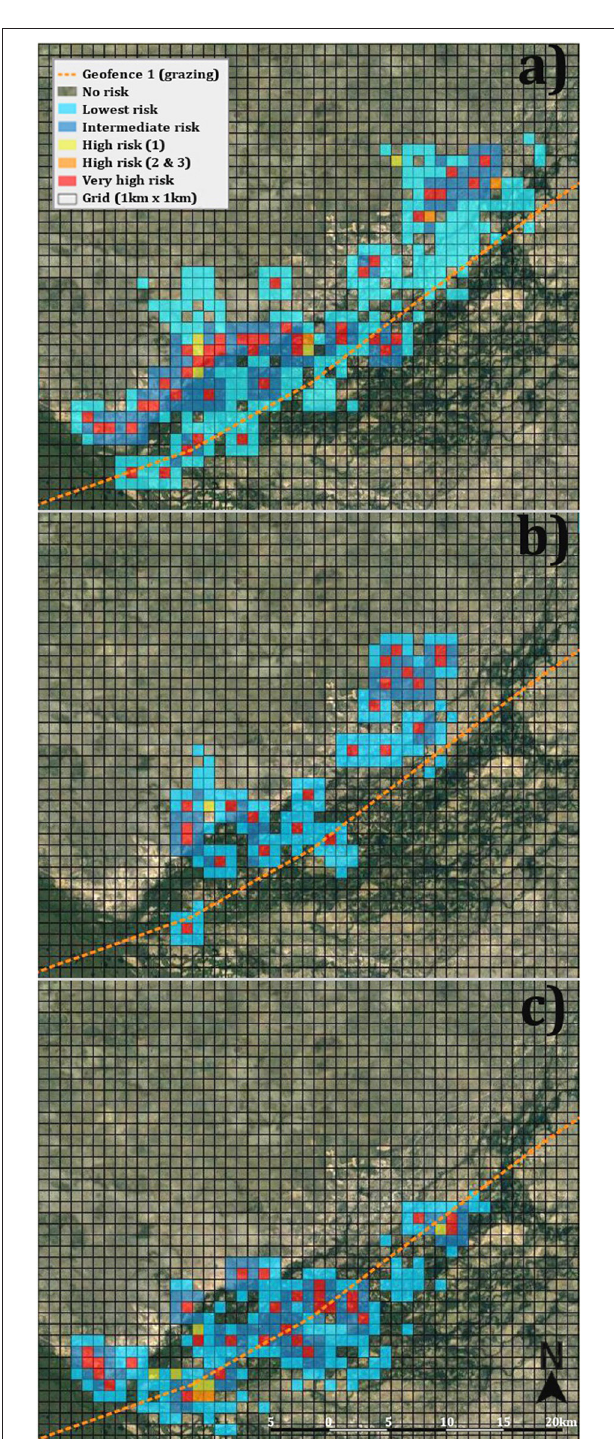
FIGURE 7 | Seasonal geo-assessment of lion risk to cattle, showing (a) the wet, (b) the early dry, and (c) the late dry seasons of 2017. Risk levels are mapped into a 1.0km × 1.0km grid across the study area. Each grid cell is hot-cold color-coded to indicate relative risk level. Yellow (1) and orange (2 or 3) indicate the number of instances in which lions approached to within 1.0km of tracked cattle. Red cells are those in which either kills occurred, or there were > 3 records of lions within 1.0km of tracked cattle.